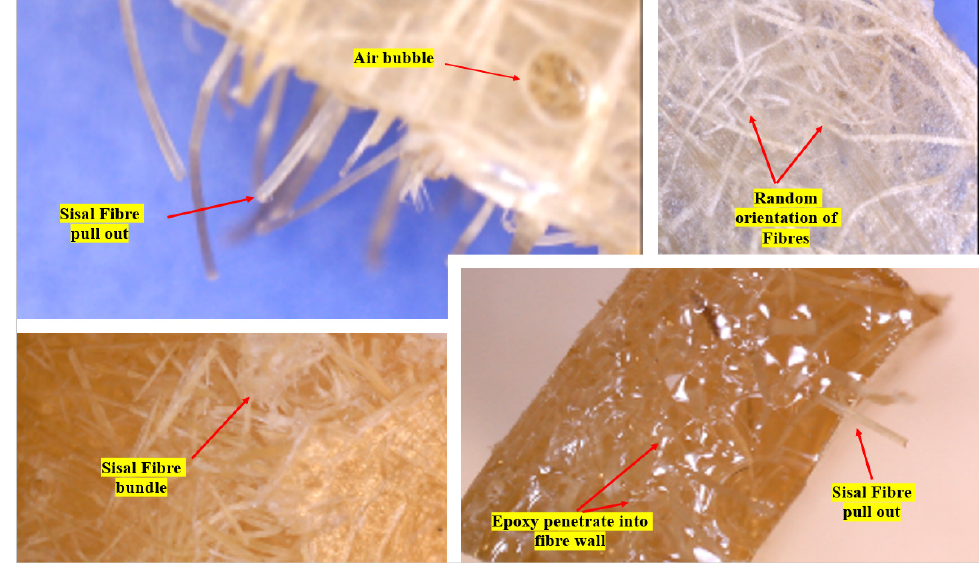
Figure 21. Microstructural images of the SFRE composite samples.